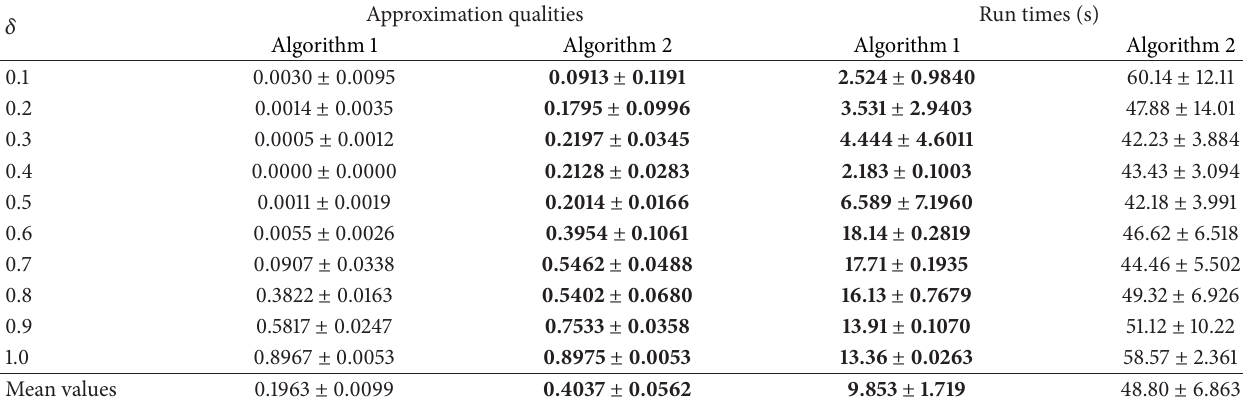
Table 7: The comparison between decision-monotonicity criterion based reducts and cost based reducts (Dermatology).